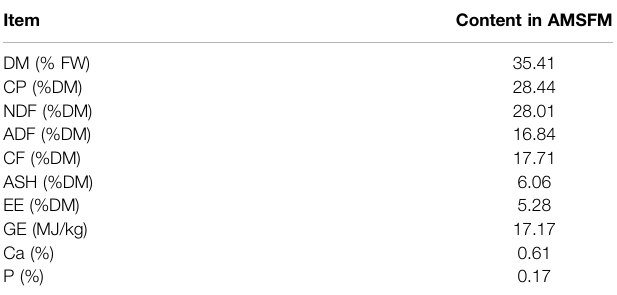
TABLE 2 | Composition and nutrient levels of basal diets for meat geese (air-dry